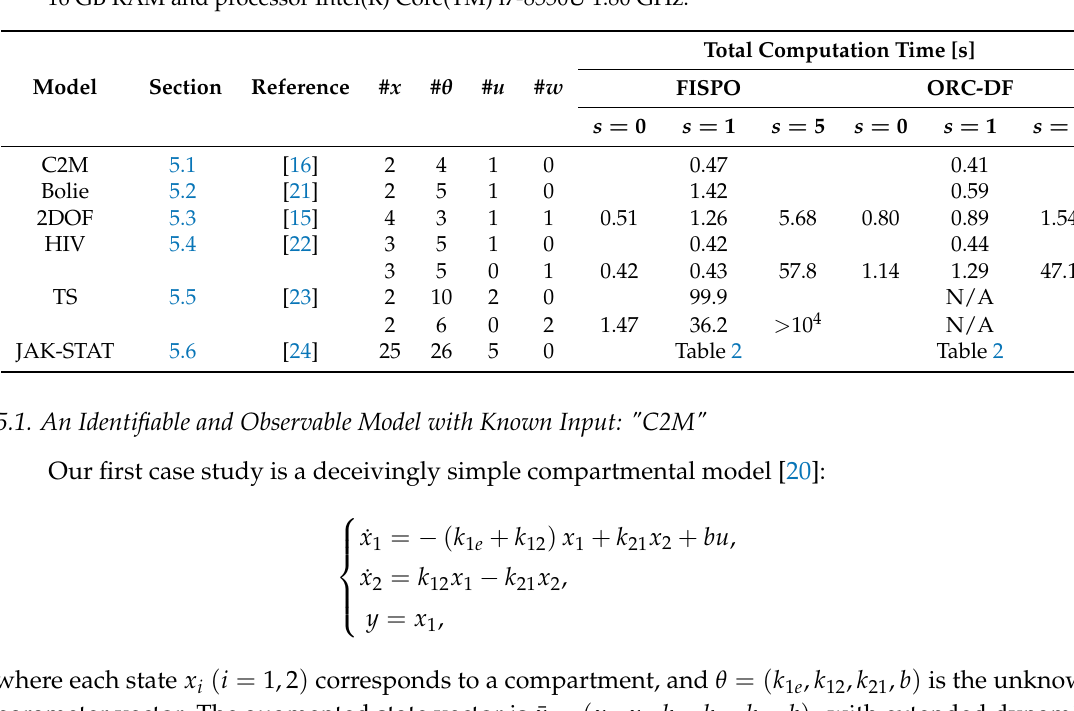
Table 1. Computation times of the two algorithms for the models analysed in this study. The computation times of case studies with unknown inputs depend on the highest order of the derivatives of the unknown inputs that are assumed to be non-zero, s . Three different cases are shown for those models: s = { 0,1,5 } . For models without unknown inputs this setting does not apply. Cases in which an algorithm cannot be applied are labelled as N/A. Results were obtained on a personal computer